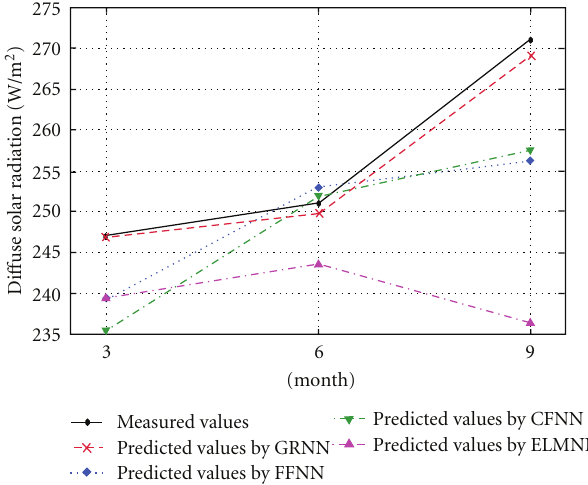
Figure 10: Comparison of measured and predicted values based on monthly averages of di ff use radiation.